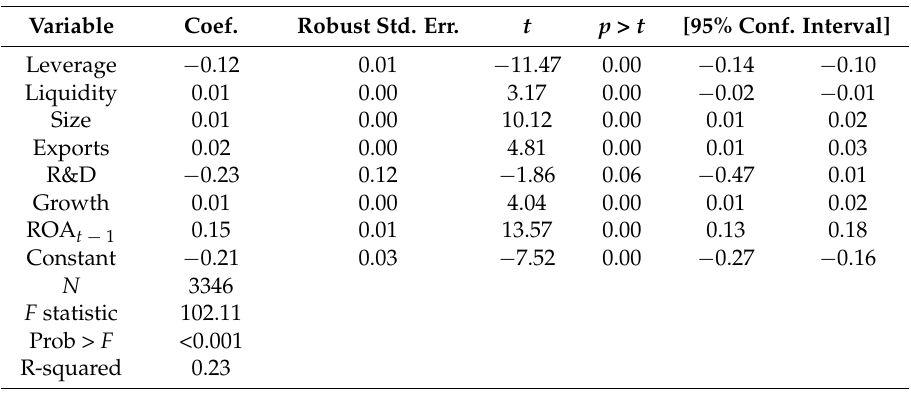
Table 4. Estimation